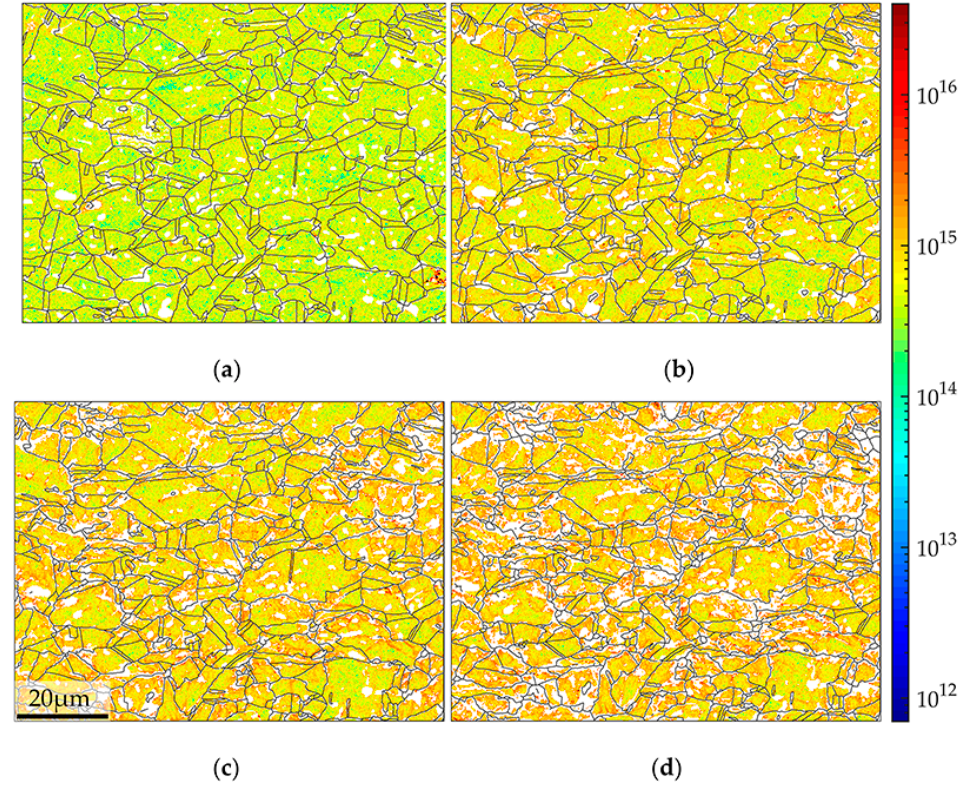
Figure 6. The spatial distribution and density of geometrically necessary dislocation density at strains of ( a ) 0% ( b ) 12% ( c ) 18% and ( d ) 24%. Units, m − 2 .